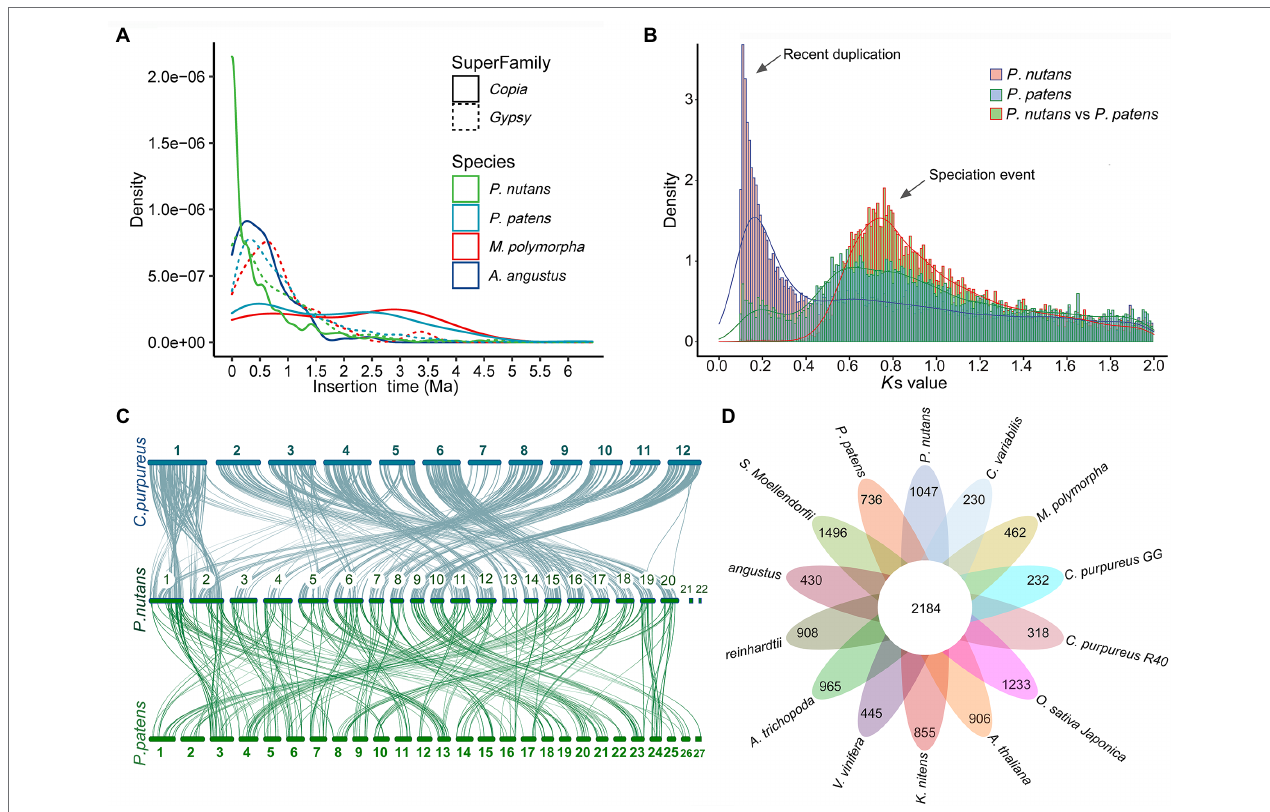
FIGURE 2 | Evolutionary and comparative genome analyses of the Antarctic moss Pohlia nutans . (A) LTR-RT ( Copia and Gypsy ) amplification analyses of four bryophytes (the Antarctic moss P. nutans , the moss model plant Physcomitrella patens , the liverwort model plant Marchantia polymorpha , the hornwort model plant Anthoceros angustus ). (B) Whole-genome duplication and speciation events identified between P. nutans and P. patens . (C) The intergenomic synteny analysis between the genomes P. nutans , Ceratodon purpureus , and P. patens . (D) Comparison of the number of gene families identified by OrthoMCL. Several representative plants were selected for evolutionary analysis such as bryophytes ( P. nutans , P. patens , C. purpureus , M. polymorpha , and A. angustus ), algae ( Chlamydomonas reinhardtii , Chlorella variabilis , and Klebsormidium nitens ), fern ( Selaginella Moellendorfii ), monocots ( Oryza sativa and Vitis vinifera ), eudicots ( Arabidopsis thaliana , A. trichopoda , and Clematoclethra variabilis ). The Venn diagram shows the shared and unique gene families in green plants of different evolutionary